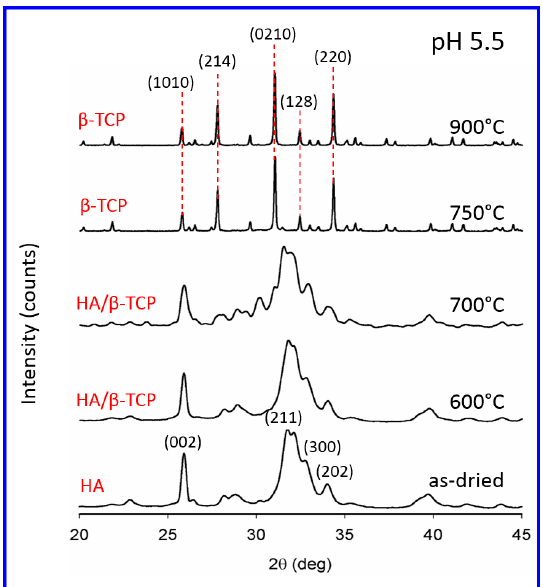
Figure 2. XRD patterns of the samples that were synthesized at pH 5.5. The effect of the sintering temperature on the chemical transformation of Ca-deficient hydroxyapatite (CDHA) to β -tricalcium phosphate ( β -TCP) is revealed. Transformation to β -TCP is almost complete as early as 750 °C. The effect of pH on the formation of β -TCP is presented in Figures 3a,b and 4a,b, for two different sintering temperature values. For each reaction pH and the related sintering condition, the percentage of transformed β -TCP, the average crystallite size, and the degree of crystallinity were quantified from the area using characteristic peaks via DIFFRAC.EVA software (Bruker AXS GmbH, Karlsruhe, Germany) and are given in Figures 3d and 4d.